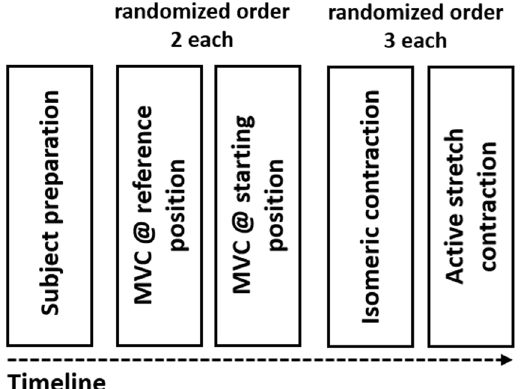
Figure 1. Schematic timeline of the performed experiment, measuring plantar-flexion torque. After the subject preparation, the participant did two maximum voluntary contractions (3–5 s) at the starting (13.3 ± 0.4° dorsiflexion) and reference position (13.0 ± 0.4° plantar flexion) in randomized order. These contractions were followed by either isometric (13.0 ± 0.4° plantar flexion) or active stretch contractions (Range of motion: 26.3 ± 0.4°. Angular velocity: 60°s − 1 ) executed in randomized order with an activation level of 30% MVC. Rest between the different contractions was set to a minimum of 3 minutes 30